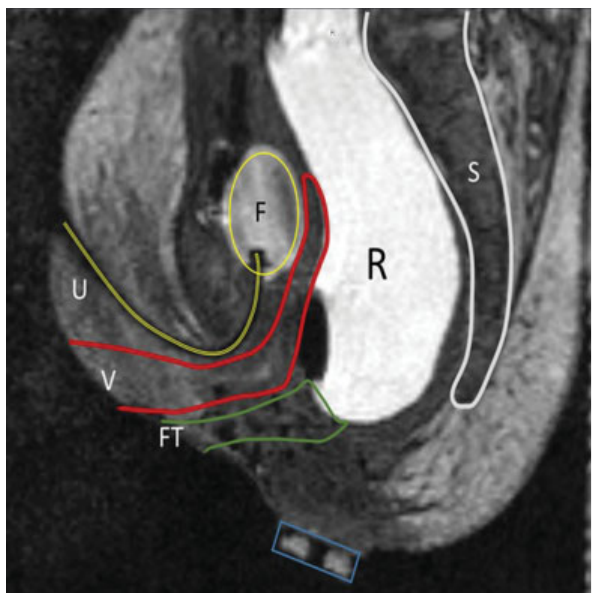
Fig. 2 Sagittalmagnetic resonance image (MRI) of the patient with failed primary posterior sagittal anorectoplasty for vestibular fi stula. F, Foley; FT, previous fi stula tract; R, rectum; S, sacrum; U, urethra; V,